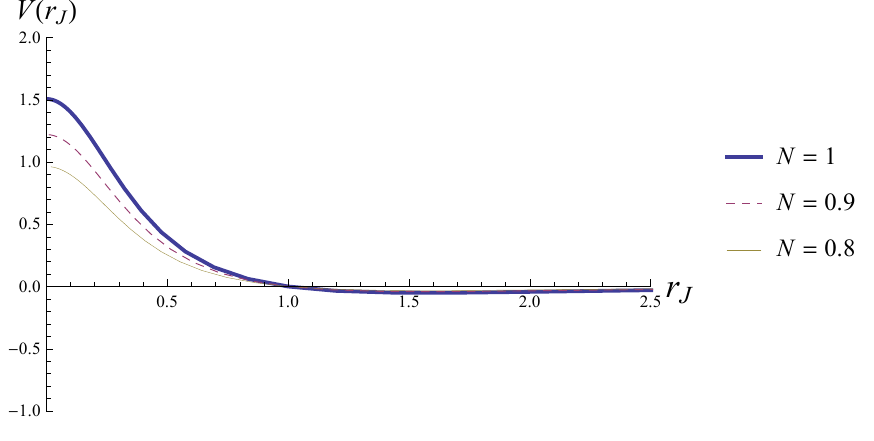
Figure 6. The potential V ( r J ) in the Jordan frame for H = − 1/2 (phantom sector) and N = 1, 0.9,